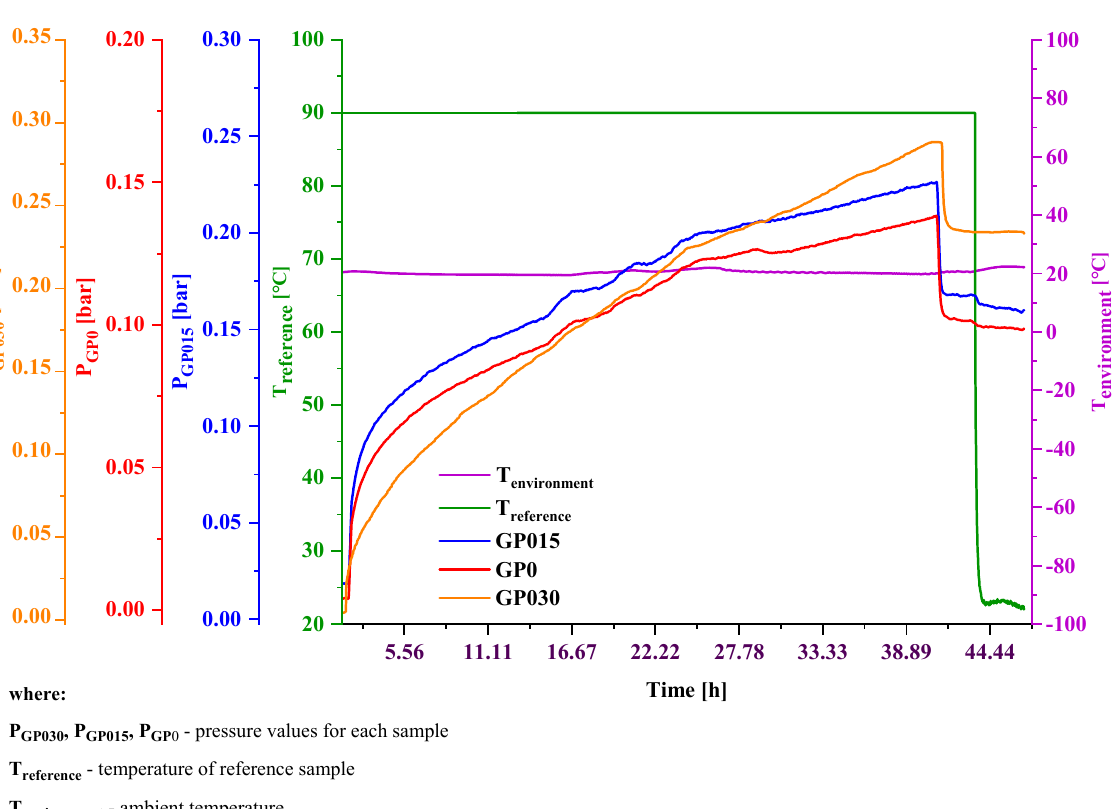
Figure 14. Temperature profiles for PSAN_0 based composite mixtures with various TEGDN con-